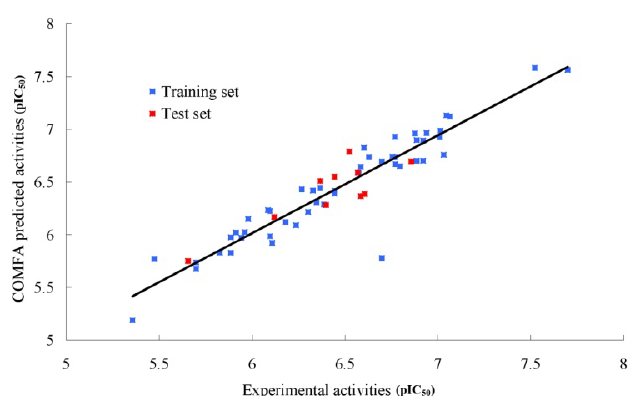
Figure 3. Correlation between the experimental and CoMFA (Comparative Molecular Field Analysis) predicted activities of compounds.